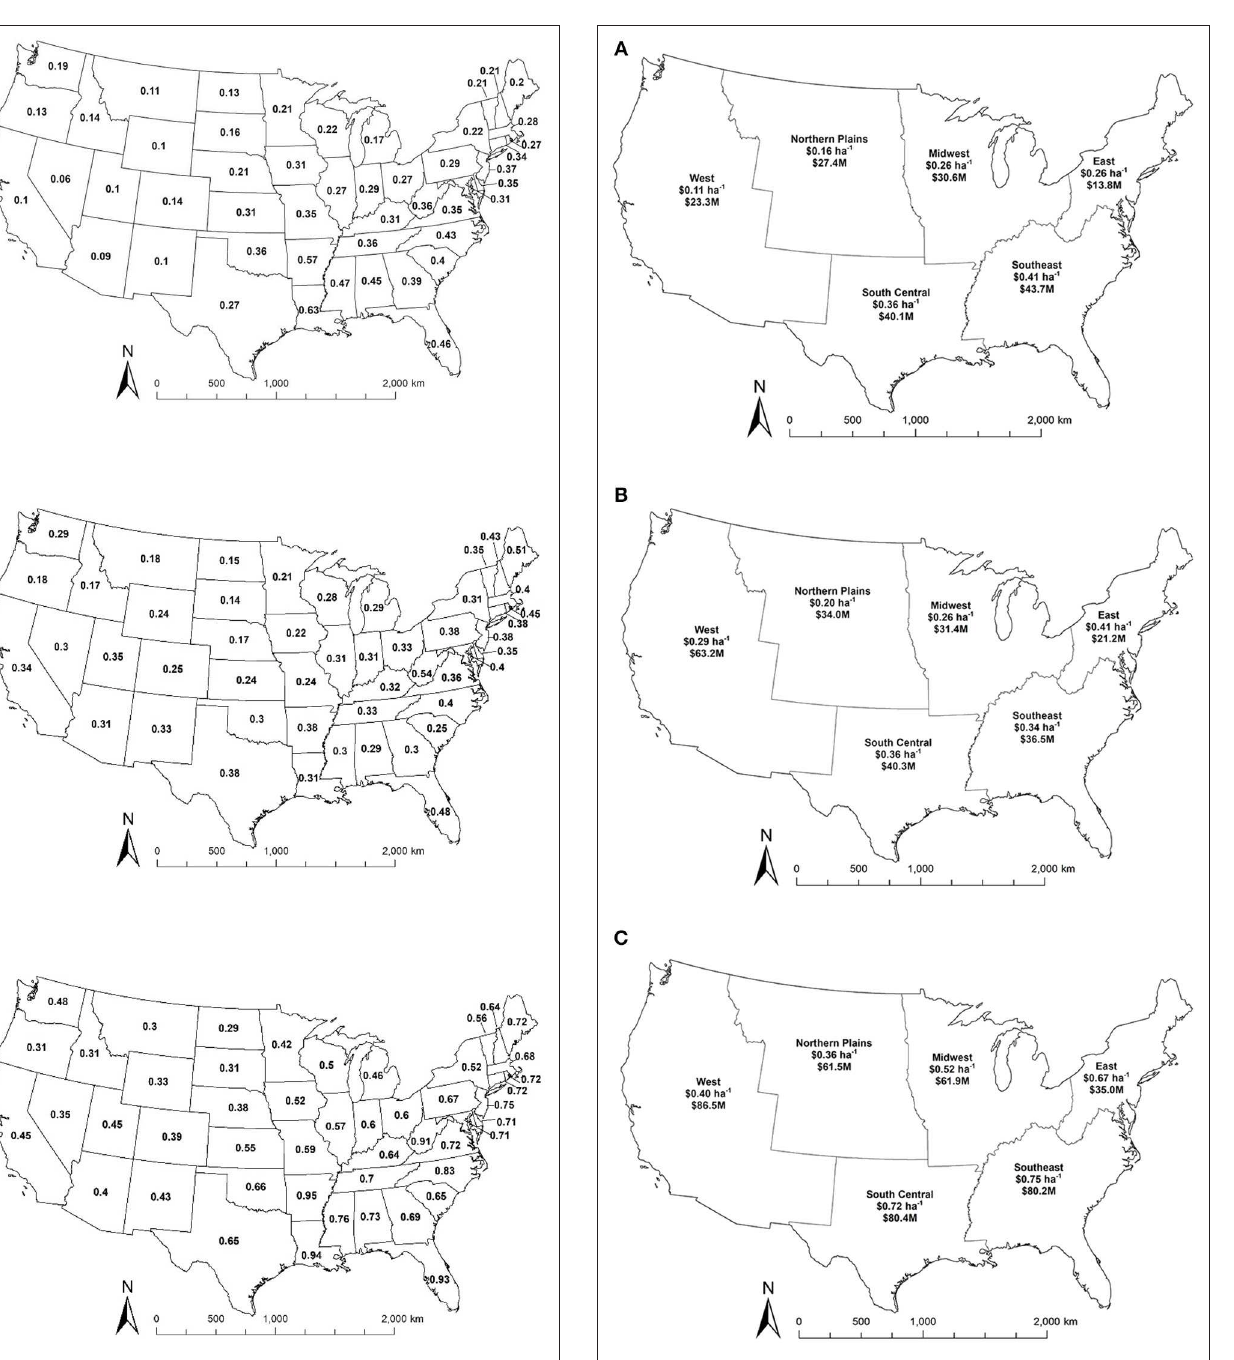
decision-making about agricultural production (Groshans et al., 2018a,b). This study quantified and mapped contribution of in the contiguous United States based on fertilizer replacement